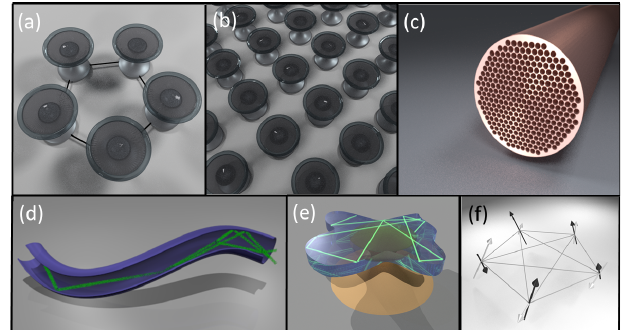
FIG. 1. A variety of photonic nonlinear multimode networks, whose field dynamics is modeled by an effective coupled mode theory of the type given by Eqs. (1) and (2). (a) A one- dimensional and (b) two-dimensional photonic lattice consisting of coupled microresonators. (c) A multicore fiber. (d) A multi- mode fiber. (e) A deformed multimode (micro)resonator with underlying chaotic dynamics. (f) A network of coupled “ soft ” (size-modulated) spins. The corresponding Hamiltonian has similarities but also crucial differences with the Hamiltonian that describes a photonic multimode